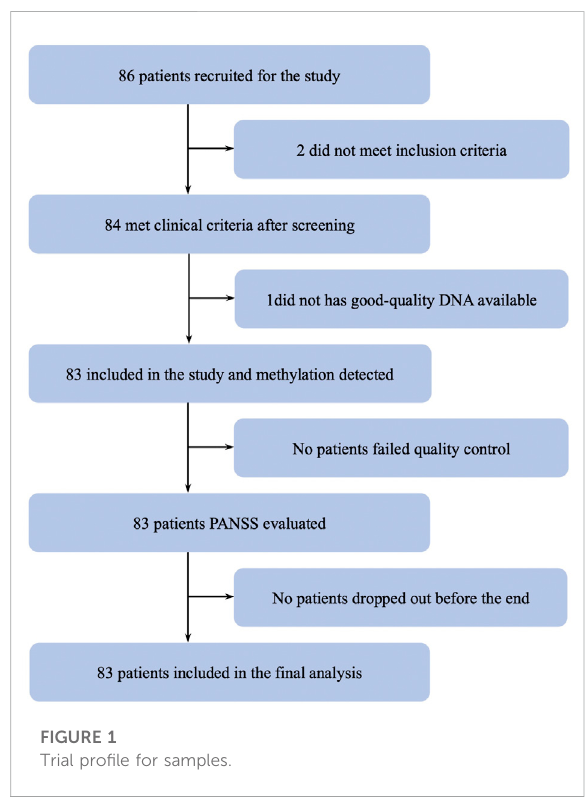
FIGURE 1 Trial pro fi le for